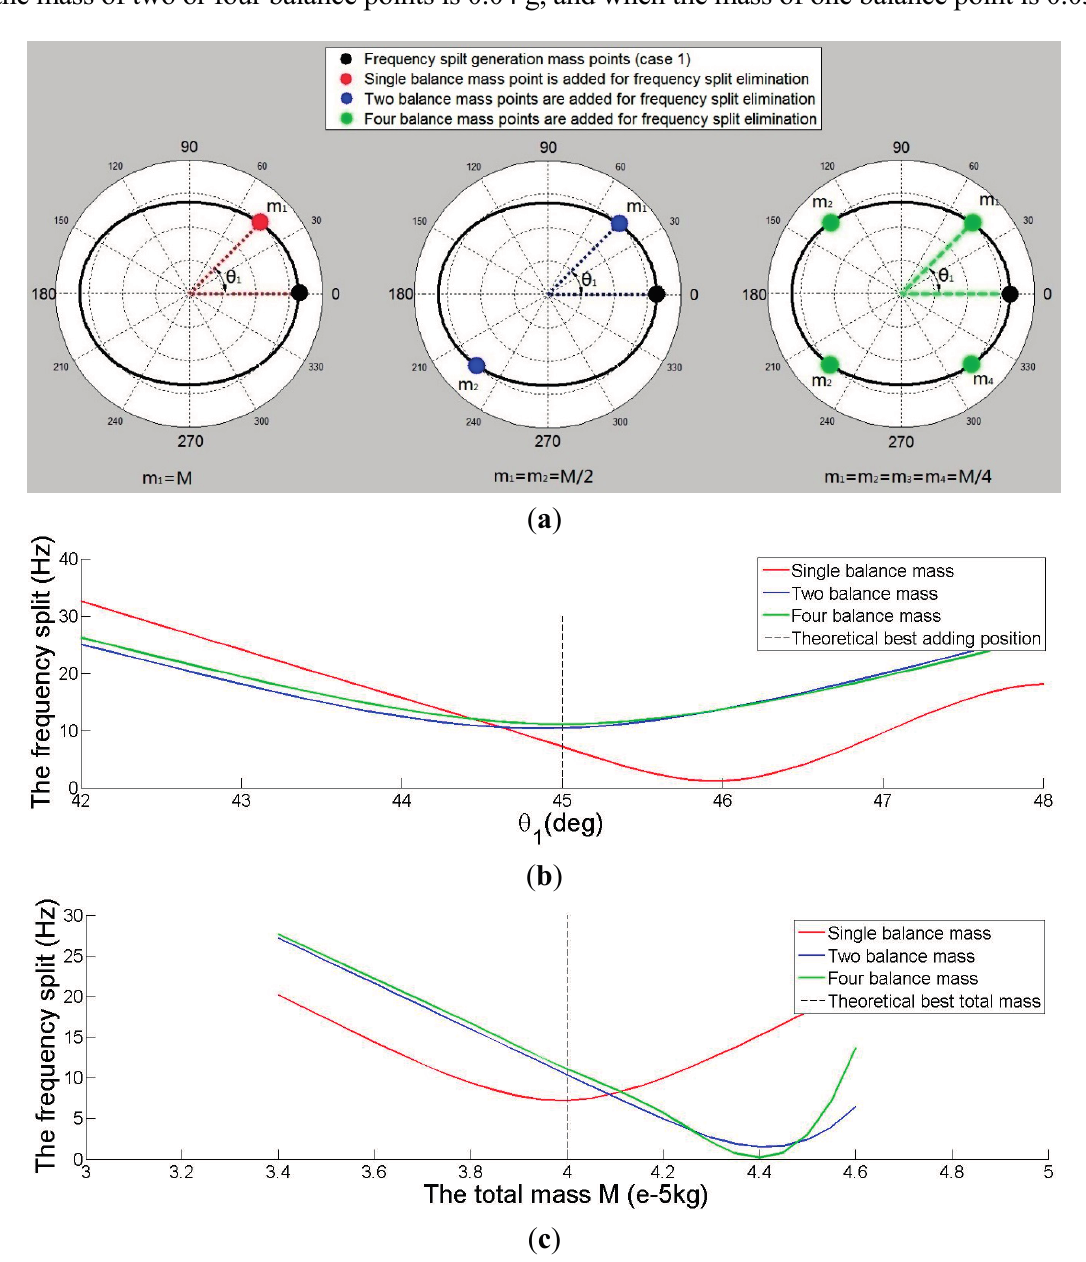
Figure 11. ( a ) The distribution of adding mass points for eliminating frequency split Case 1; ( b ) The relationship between θ 1 and frequency split for eliminating frequency split Case 1 ( M = 0.04 g); ( c ) The relationship between mass of balance points M and frequency split for eliminating frequency split Case 1 ( θ 1 = π